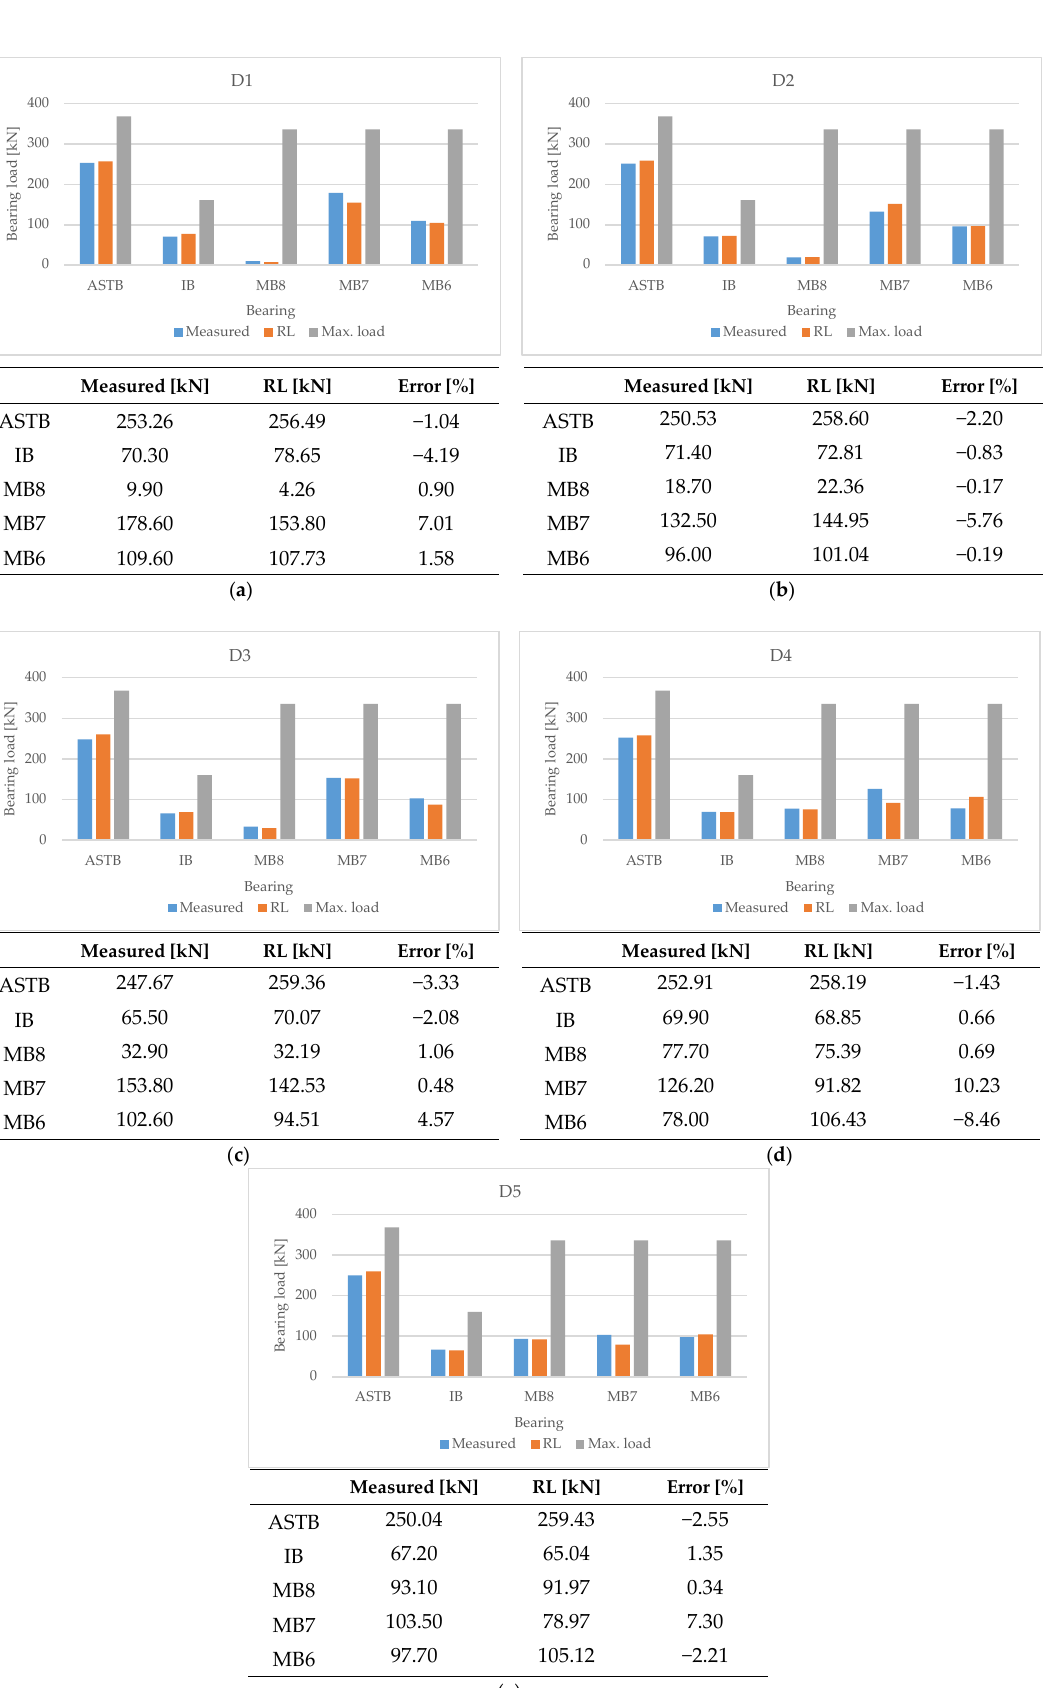
Figure 22. Comparison of predicted bearing reaction force with measurements of ( a ) D1, ( b ) D2, ( c ) D3, ( d ) D4, and ( e ) D5.